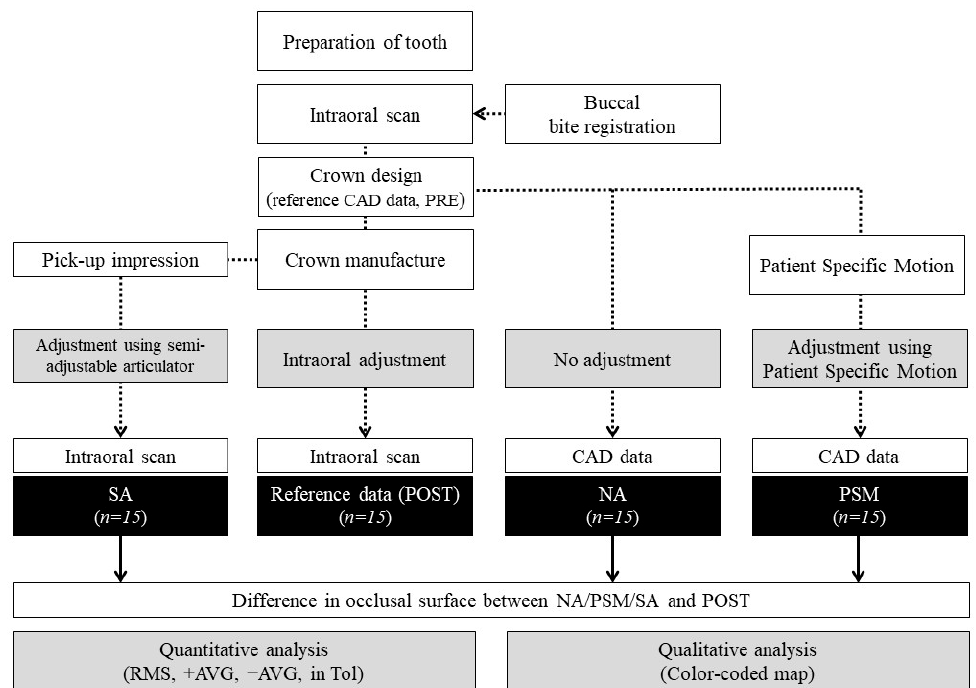
Figure 1. Workflow that was used to compare the amount of occlusal error between the experimental groups. CAD, computer-aided design; NA, no adjustment group; PSM, Patient Specific Motion group; SA, semi-adjustable articulator group; RMS, root mean square; AVG, average; in Tol, inside the tolerance level.